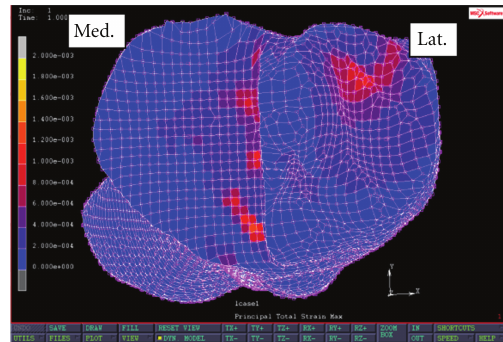
Figure 6: Maximum principal strain at implant-bone interface of a PKR knee with a superior screw design.